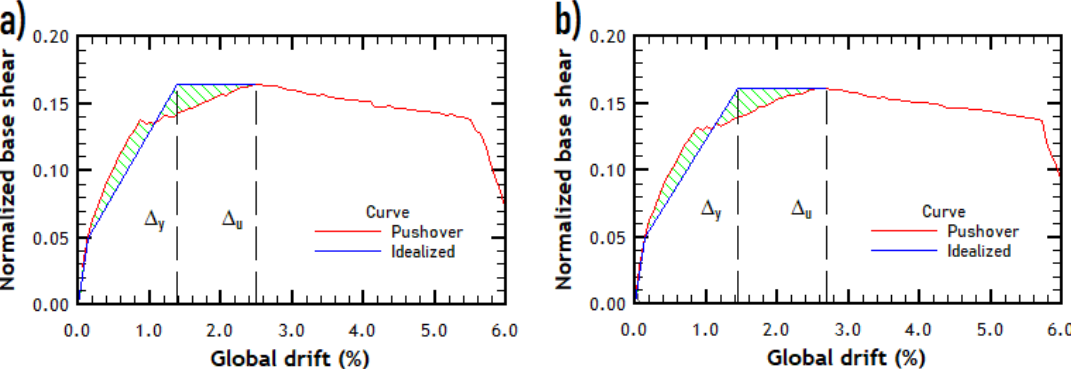
Figure 8. Resulting capacity and idealized curves obtained from conventional pushover: ( a ) lateral forces (+) and ( b ) lateral forces ( − ).